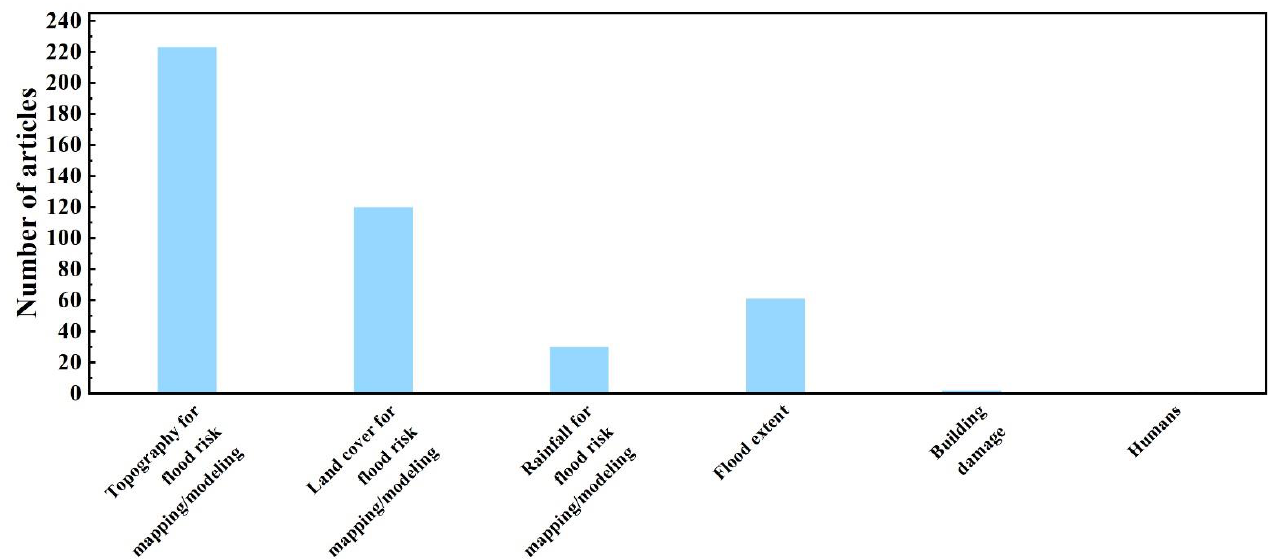
Figure 4. Number of articles corresponding to observations.